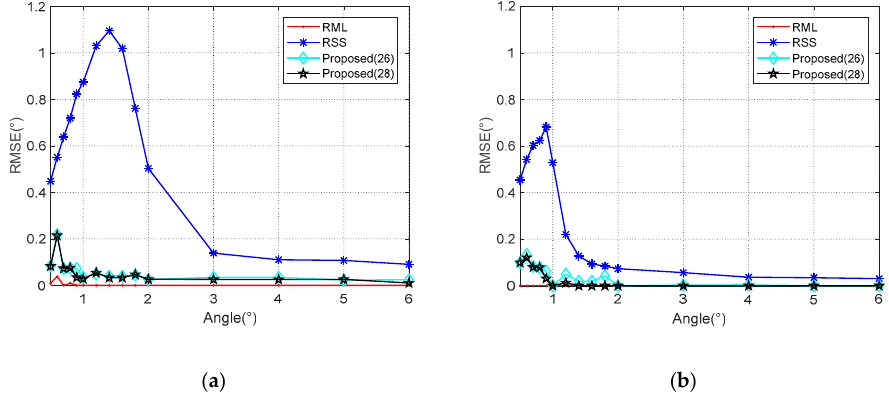
Figure 8. RMSE against elevation angle 𝜃 in different SNR when 𝜌 = −0.95 . ( a ) 𝑆𝑁𝑅 = 0 dB; ( b ) 𝑆𝑁𝑅 = 10 𝑑𝐵.